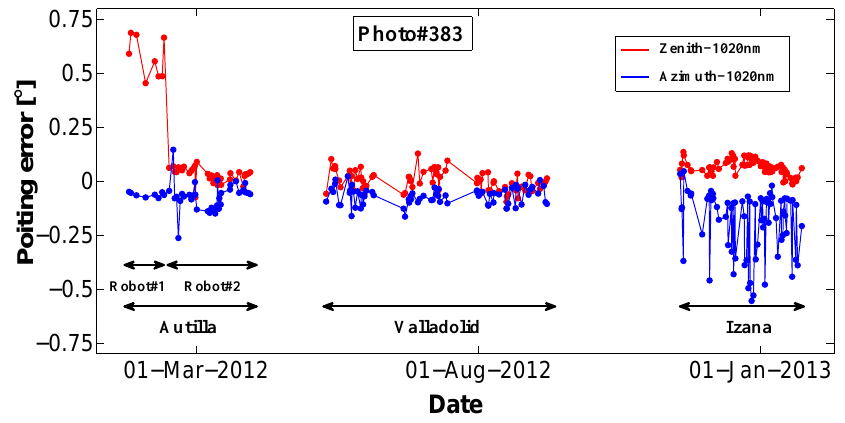
Fig. 12. Time series of zenith and azimuth pointing error derived from cross measurements for Sun photometer #383 during 2012.